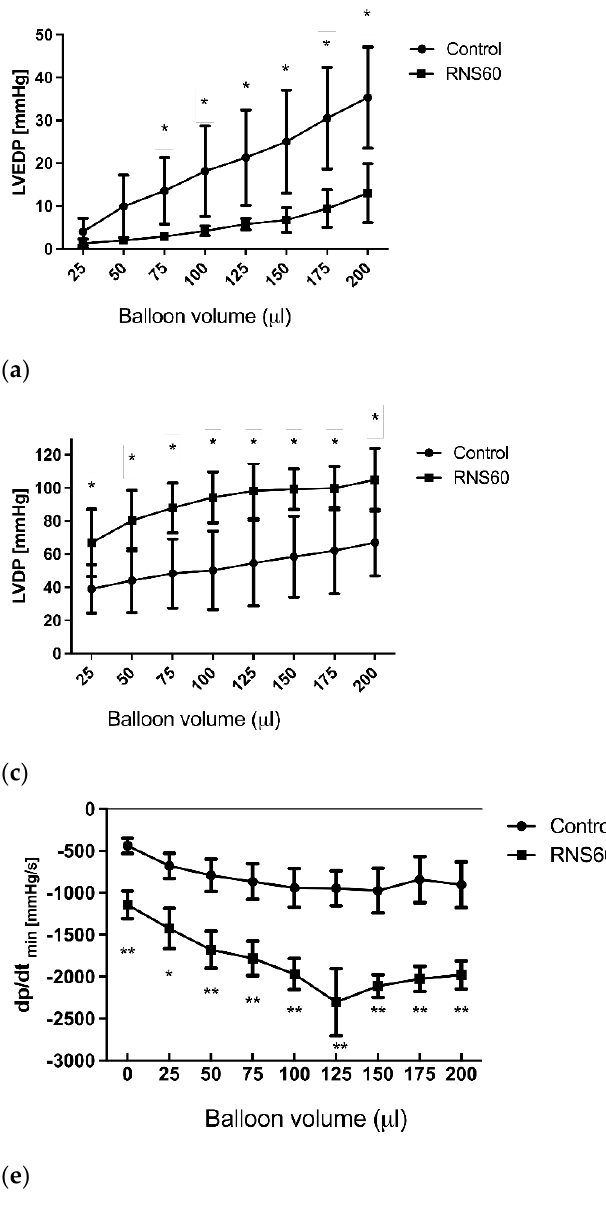
Figure 3. ( a ) Left ventricular end-diastolic pressure (LVEDP), ( b ) left ventricular systolic pressure (LVSP), ( c ) left ventricular systolic pressure (LVDP), ( d ) values of dp/dt max , and ( e ) values of dp/dt min - volume relation of the rat heart after 4 h of hypothermic ischemia in the control and the group that received cardioplegia with RNS60. Values represent mean ± SEM (n = 5); * p < 0.01, ** p <